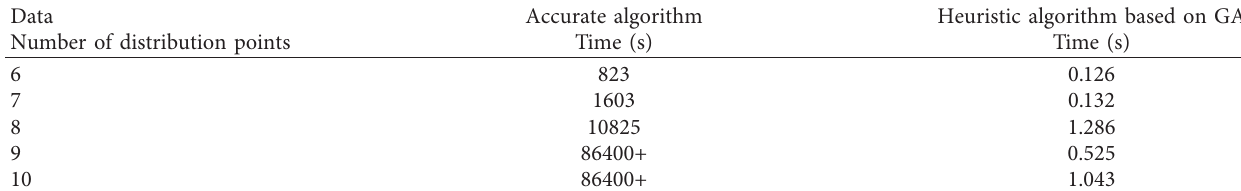
Table 4: Parameter settings of different types of